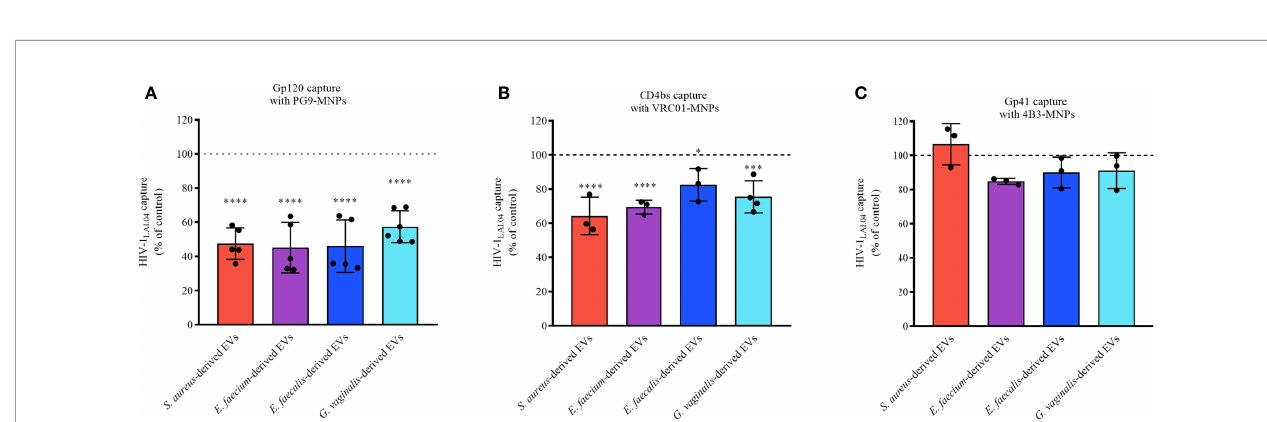
FIGURE 6 | Effect of cell pre-exposure with bacterial EVs on HIV-1 infection. MT-4 cells were preincubated with bacterial EVs for 24 h, washed off, infected with HIV-1 LAI.04 , and incubated for 3 days. HIV-1 replication was evaluated from measurements of the capsid protein p24 gag in cell culture medium and is represented as a percentage of HIV-1 replication in untreated control. Presented are means±SEM from at least three independent measurements.